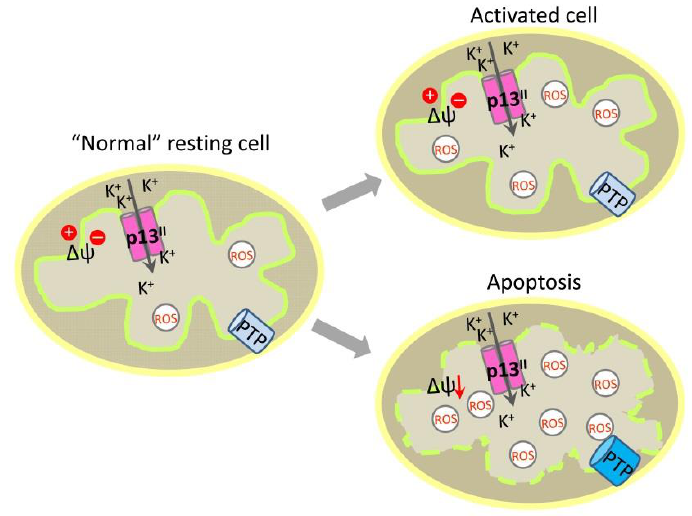
Figure 6. Model of p13 II function in T cells: p13 II forms oligomeric K + channel in inner mitochondrial membrane (IMM); K + influx affects ∆Ψ m and triggers processes that lead to ROS formation; at physiological ROS concertation, this leads to activation of the “normal” T cells; at very high toxic levels of ROS in transformed cells, this leads to apoptosis and cell death.